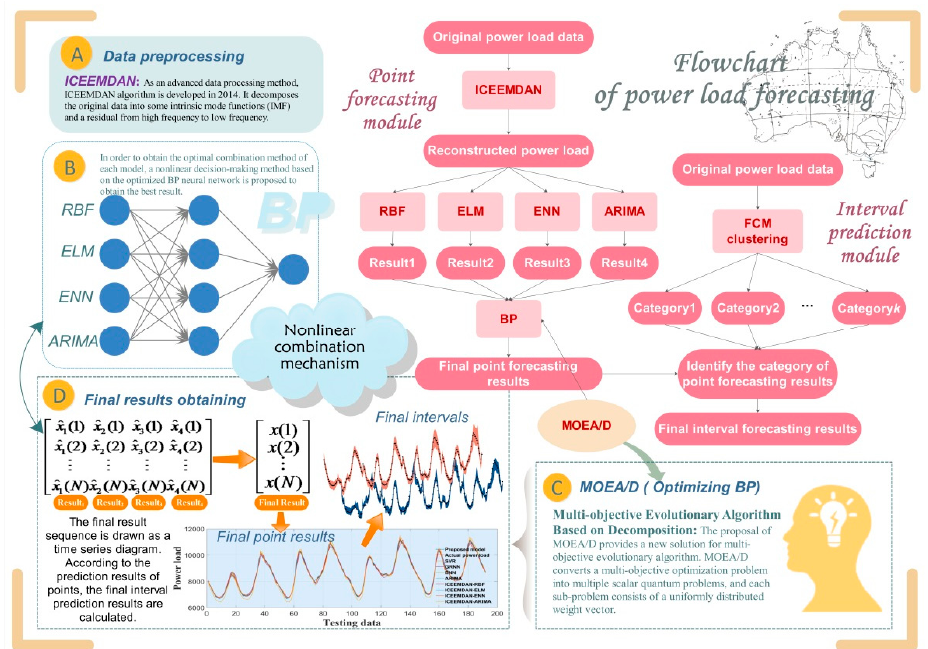
Figure 1. The flowchart of load forecasting by double hybrid model. The model construction steps are recorded in the upper right, and the methods displayed in the specific model are divided into five parts. D and E part show the results of point forecasting and interval forecasting, respectively.